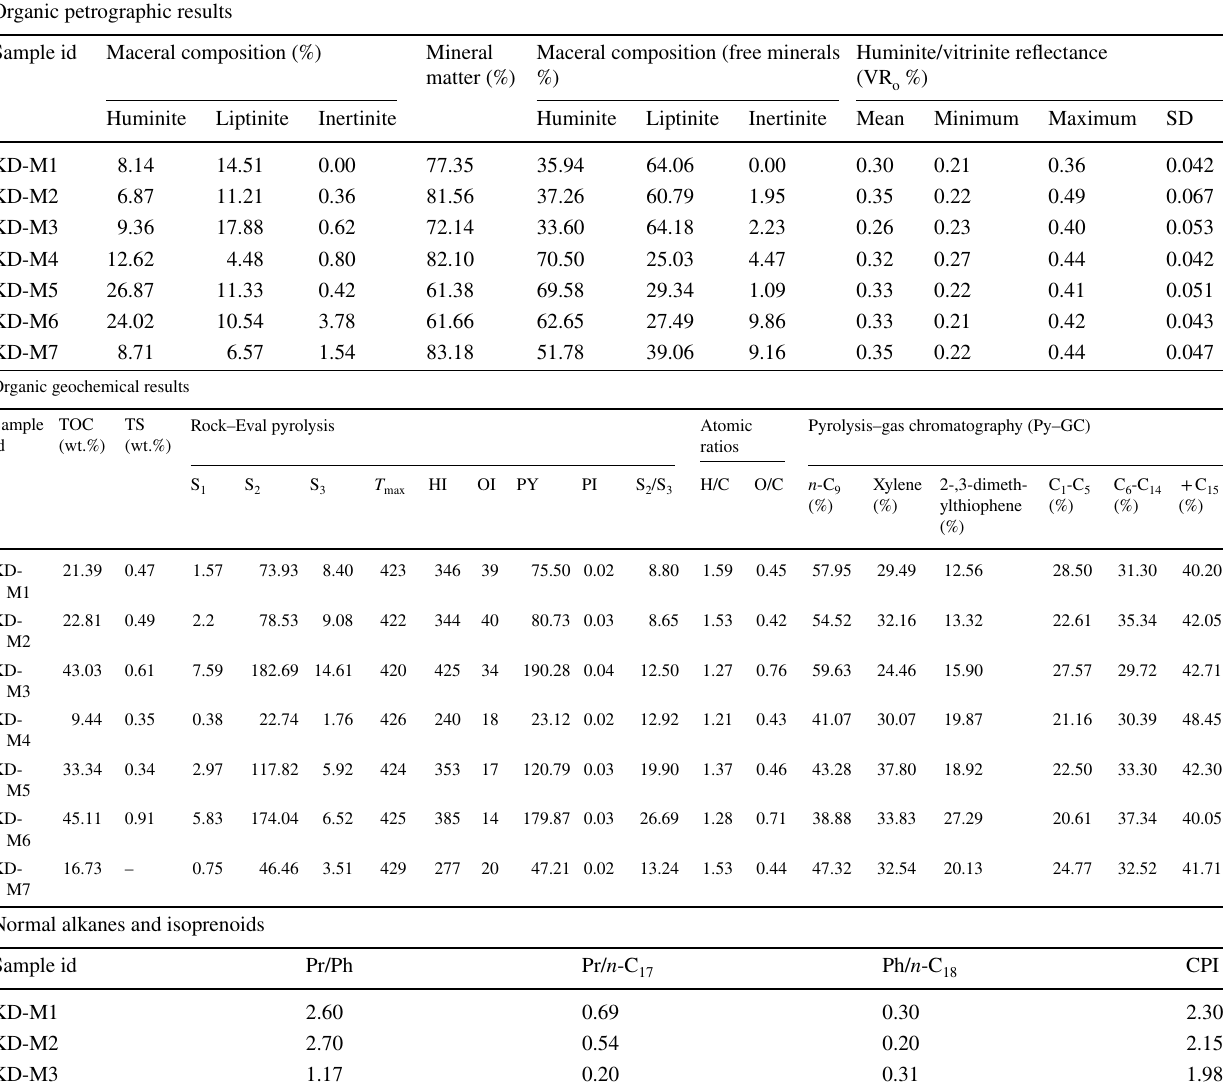
Table 1 Geochemical and organic petrographic results of the ana- lyzed bituminite shale samples from Kapurdi mine in the Barmer Basin, NW India; including TOC, TS contents, bulk Rock–Eval pyrolysis, pyrolysis–gas chromatography (Py–GC), normal alkanes